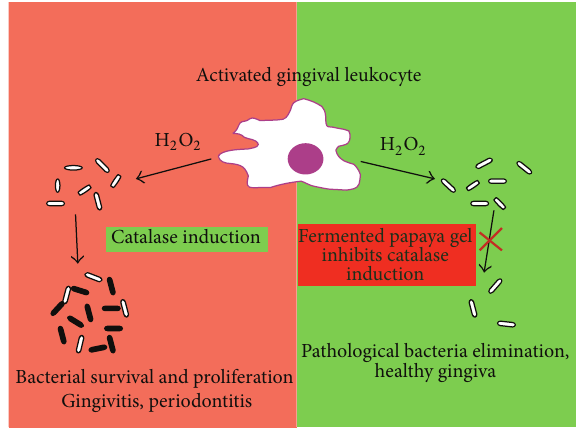
Figure 5: Standardised fermented papaya gel (SFPG) inhibits bacterial survival by the suppression of their adaptive antioxidant defence. Catalase constitutively expressed in pathogenic bacte- ria including Porphyromonas gingivalis could be further induced after phagocytosis due to intracellular oxidative stress in granulo- cytes/tissues macrophages. The adaptive catalase induction through bacterial redox sensitive regulons leads to reduced bacterial killing by reactive oxygen species and to their survival and dissemination (infection persistence). Thus, chronic bacteria-driven inflammatory process persists in the periodontal tissues (gingivitis, periodonti- tis). SFPG blocks, by unknown as yet mechanism, the adaptive antioxidant response of pathogenic bacteria to oxidative burst of granulocytes/tissue macrophages. Hence, bacteria become more sensitive to oxidative killing. Thus, bacterial load diminishes and the inflammatory process in the periodontal tissues